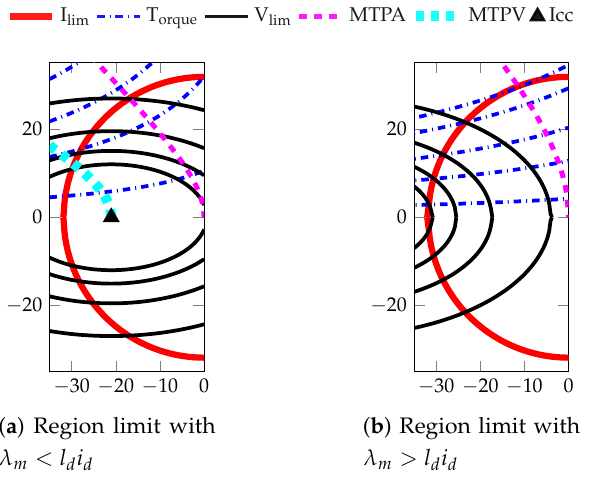
Figure 1. Operation area with an interior permanent magnet (IPM) motor with a high permanent magnet (PM) flux and low PM